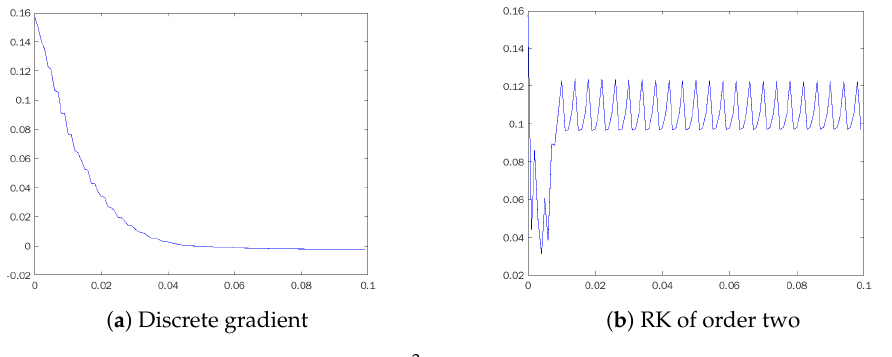
Figure 8. Lyapunov function for h = 10 − 3 . Table 1. Results of numerical experiments for the Duffing